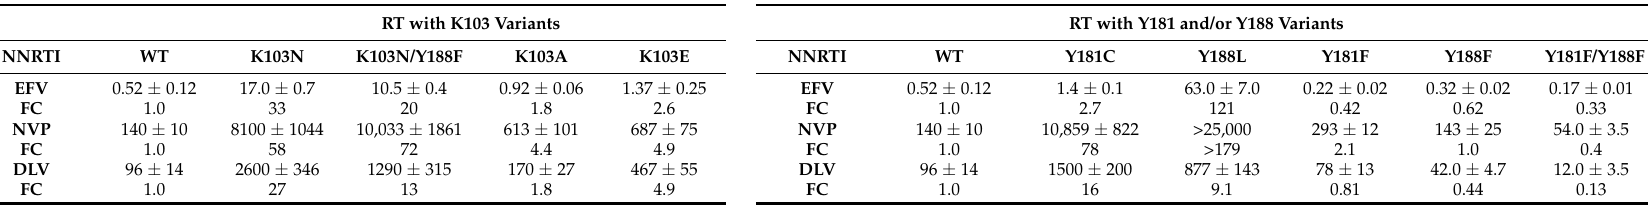
Table 2. Susceptibility calculated as the concentration of drugs required to inhibit viral replication by 50% (EC 50 , nM) of HIV-1 RT mutant viruses to NNRTIs. * Mutant viruses Containing K103 Mutations in the RT Region